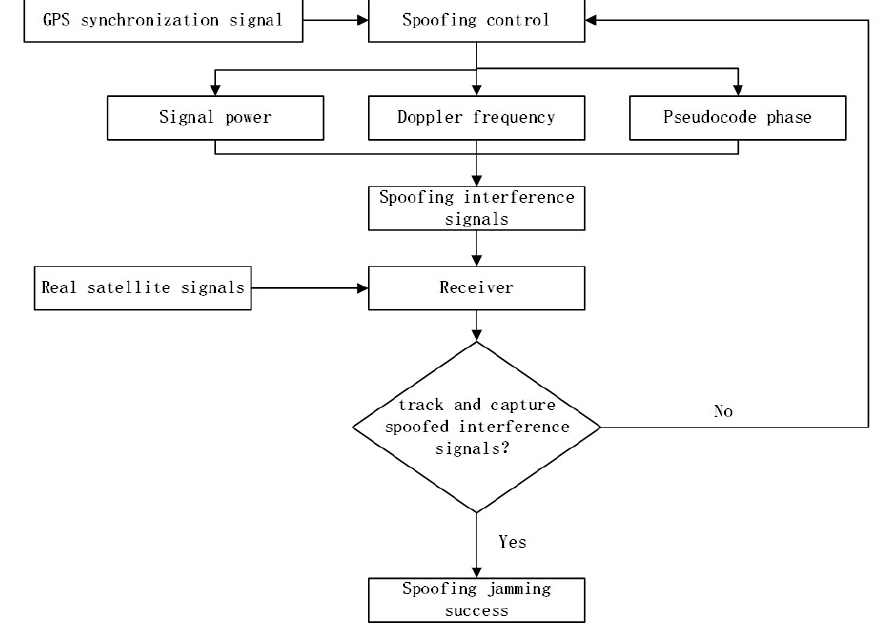
Figure 2. Generative spoofing interference process.